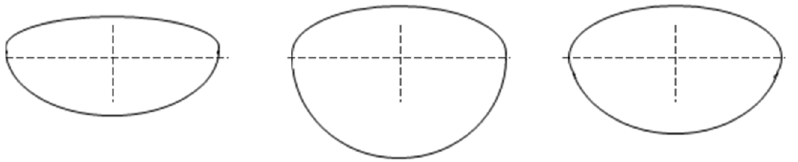
Figure 1. Varied deposited bead shape based on the different process parameters.